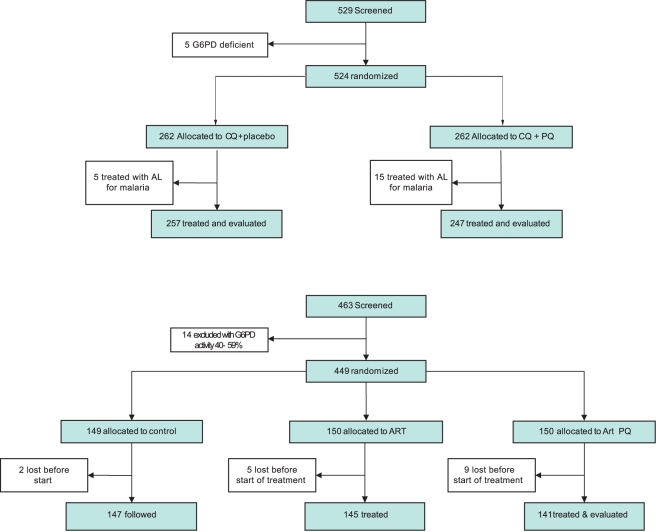
Trial profile.incomplete FU, incomplete follow-up (i.e., the study was terminated before the participant completed the 21-mo follow-up time period); LTF, lost to follow-up.